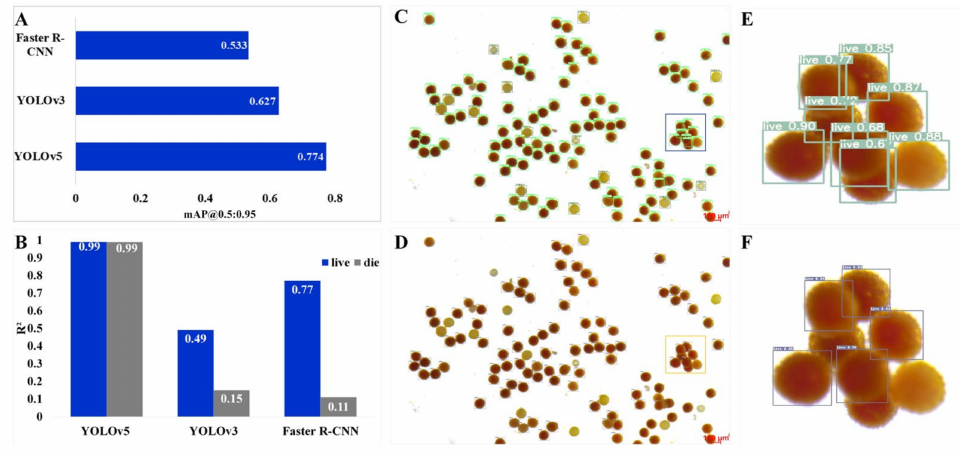
Figure 2. Performance evaluation of the pollen viability detection model based on deep learning. ( A ) The YOLOv5, Faster R-CNN, and YOLOv3 models were used to detect pollen in 16 images, and the position accuracy of the different models was judged by comparing the gap between the predicted frame position and the manually marked boundary box position. ( B ) Sixteen images were detected by the YOLOv5, Faster R-CNN, and YOLOv3 models, and the counting accuracy of the different models was judged by analyzing the correlation with the actual values ( R 2 ). ( C , D ) The visualization results of the same cotton pollen image obtained by the YOLOv5 model and YOLOv3 model, respectively. Bars: 100 µ m. ( E , F ) An enlarged image of the box in ( C , D ),